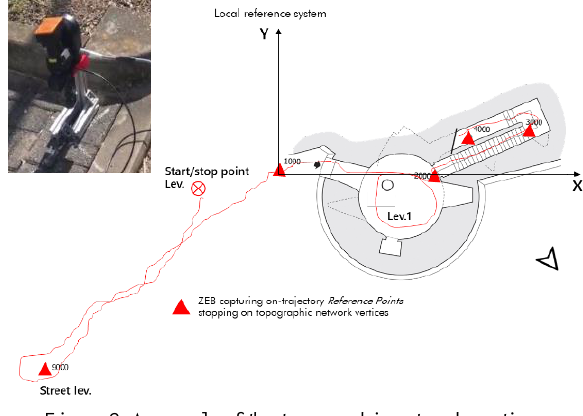
Figure 2. A sample of the topographic network vertices positions at ground and 1 st level, and the SLAM-based path mapping the reference points on the same vertices.